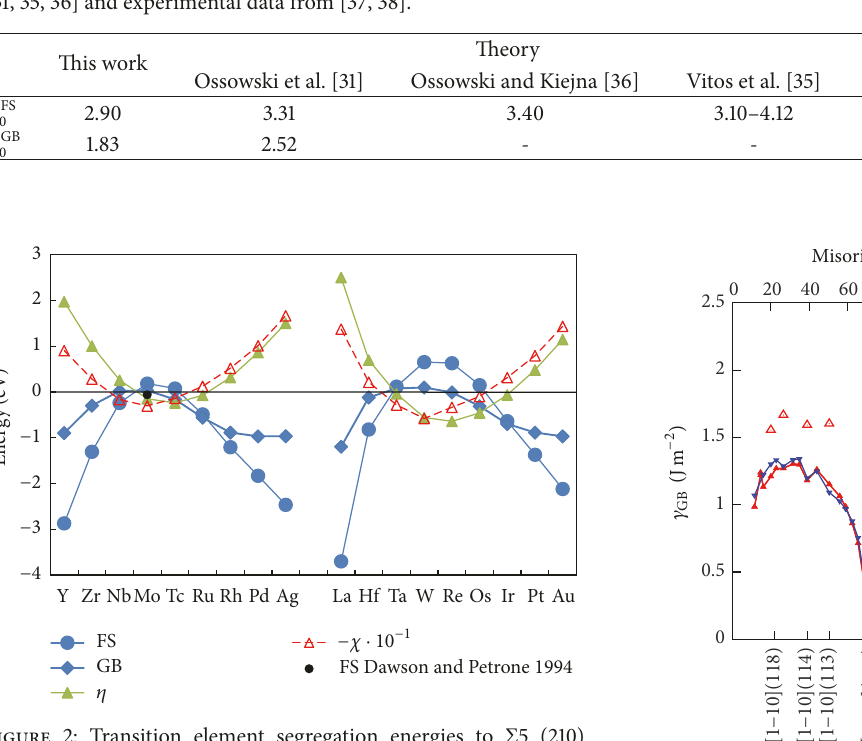
Figure 2: Transition element segregation energies to Σ 5 (210) [100] GB (filled diamonds) and to (210) FS (filled circles), the GB strengthening energy 𝜂 (filled triangles) and partial cohesive energies 𝜒 (empty triangles) in bcc Cr. An experimental data point related to Mo free surface (FS) segregation in a Cr-rich Cr-Mo alloy from [15] is shown with a black circle.